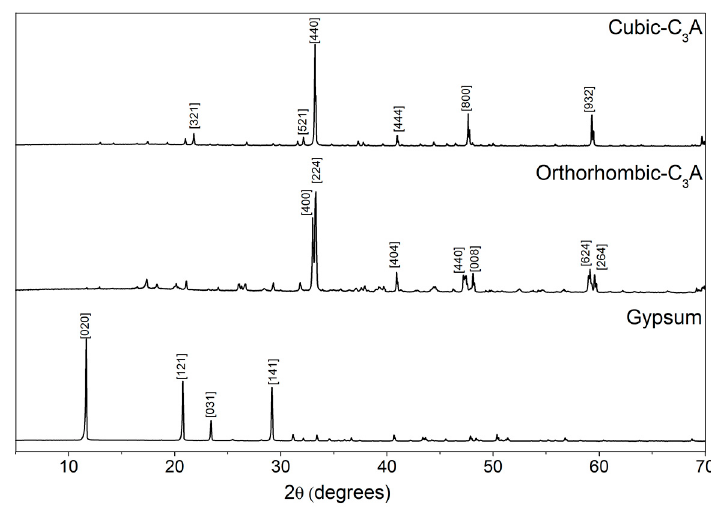
Figure 1. Cu K α diffractogram of the anhydrous cubic C 3 A, the orthorhombic C 3 A and the gypsum.